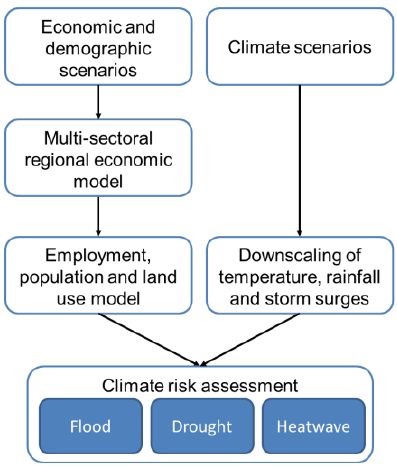
Figure 5 . Overview of a multi-sector framework for urban climate risk